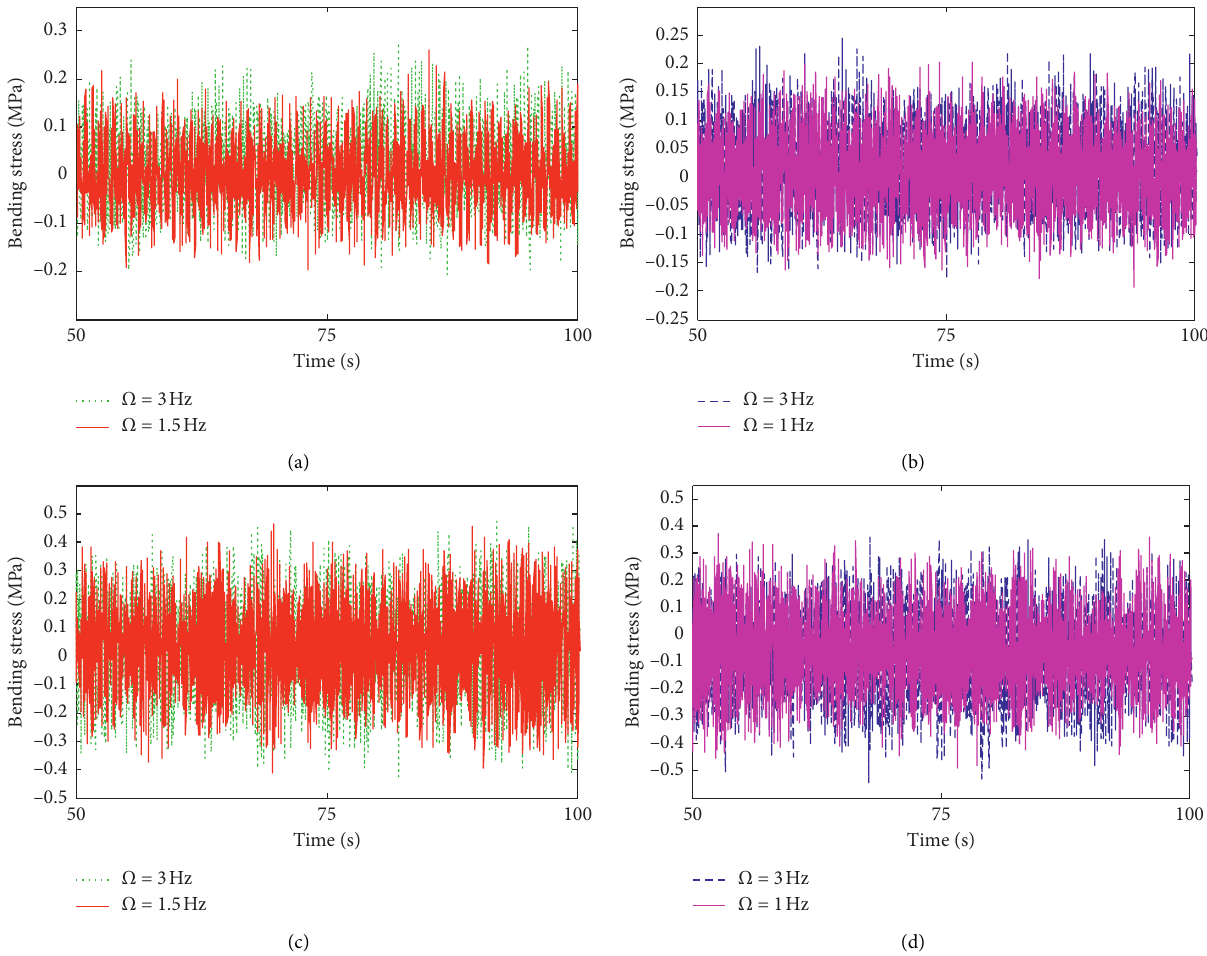
Figure 13: Bending stress time history of TTR at midpoint: (a) U � 0.3 m/s, T � 100N, and △ T � 30N; (b) U � 0.3m/s, T � 100N, and △ T � 20N; (c) U � 0.5m/s, T � 100N, and △ T � 30N; (d) U � 0.5m/s, T � 100N, and △ T � 20